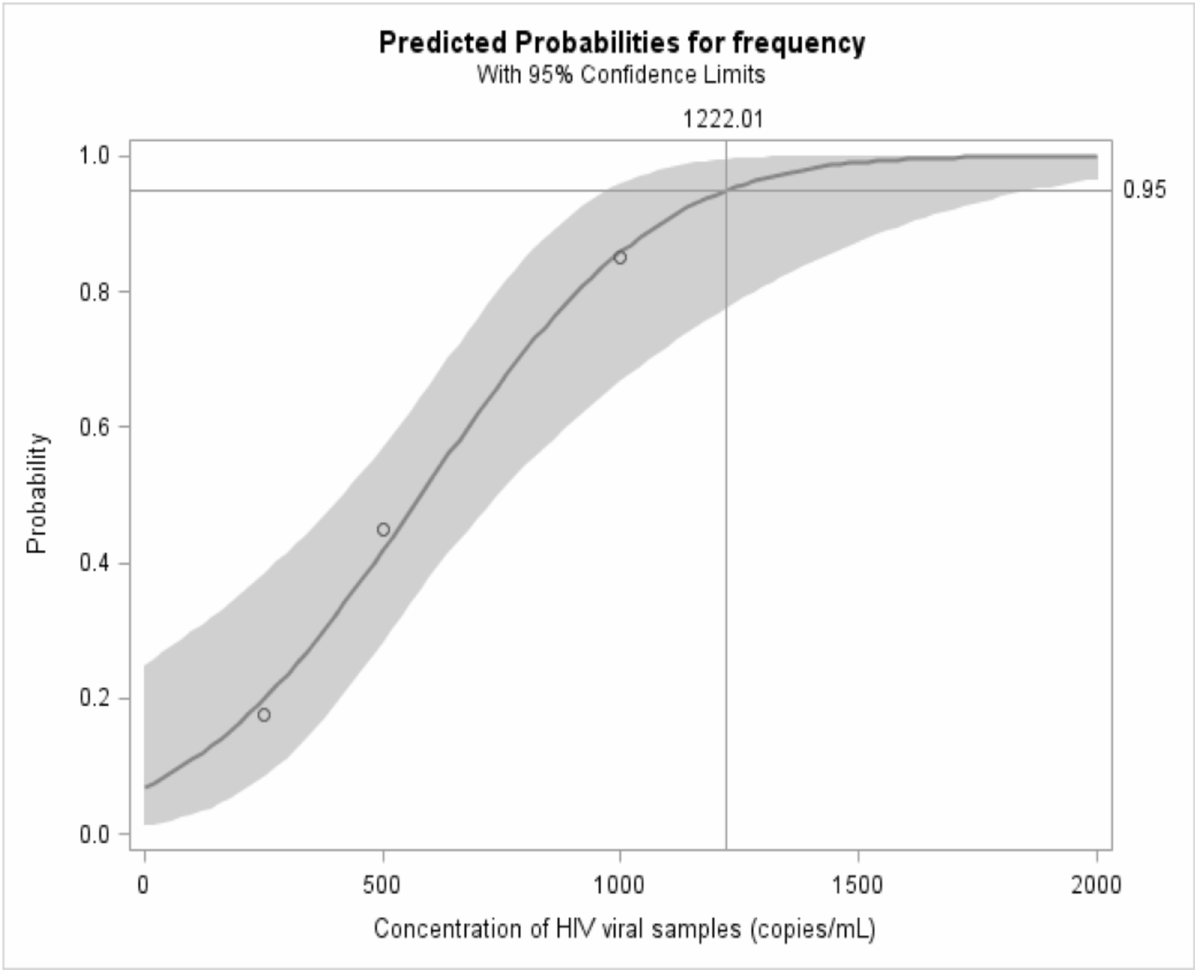
Fig 6. Probit analysis for Abbott dried blood spot viral load limit of detection. Limit of detection1,222copies/mL, 95% CI (978.12,